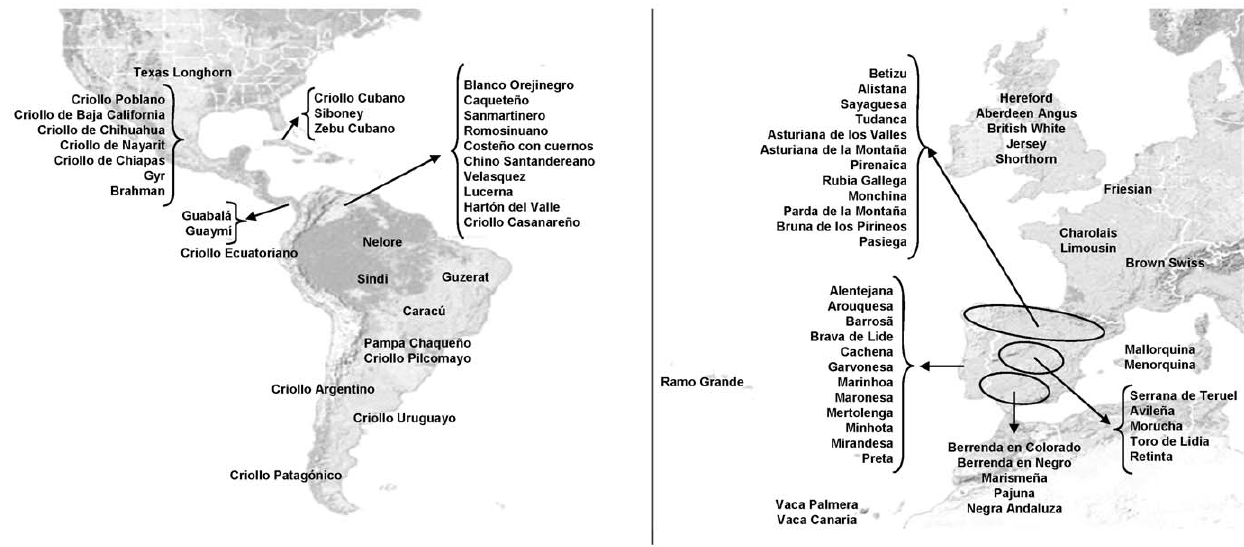
Figure 1. Geographic distribution of the 81 cattle breeds from America and Europe.